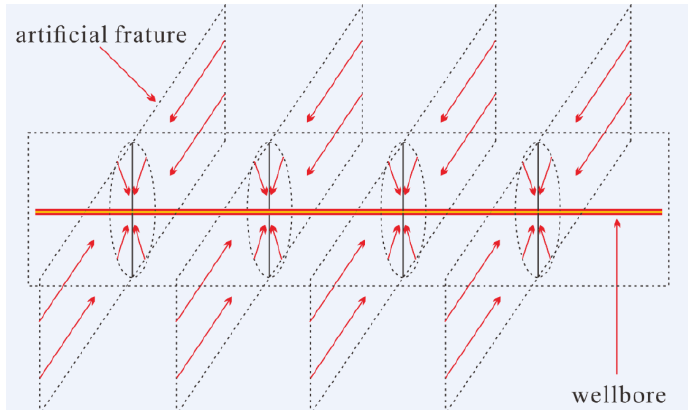
Figure 2. The schematic of seepage field in fissures of fractured horizontal well.